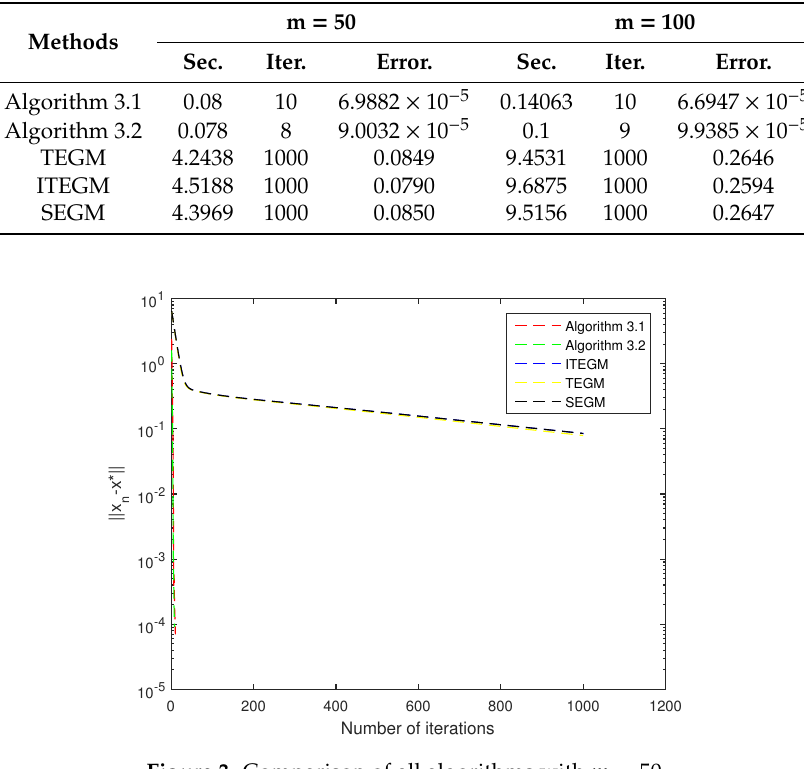
Table 2. Numerical results obtained by other algorithms.